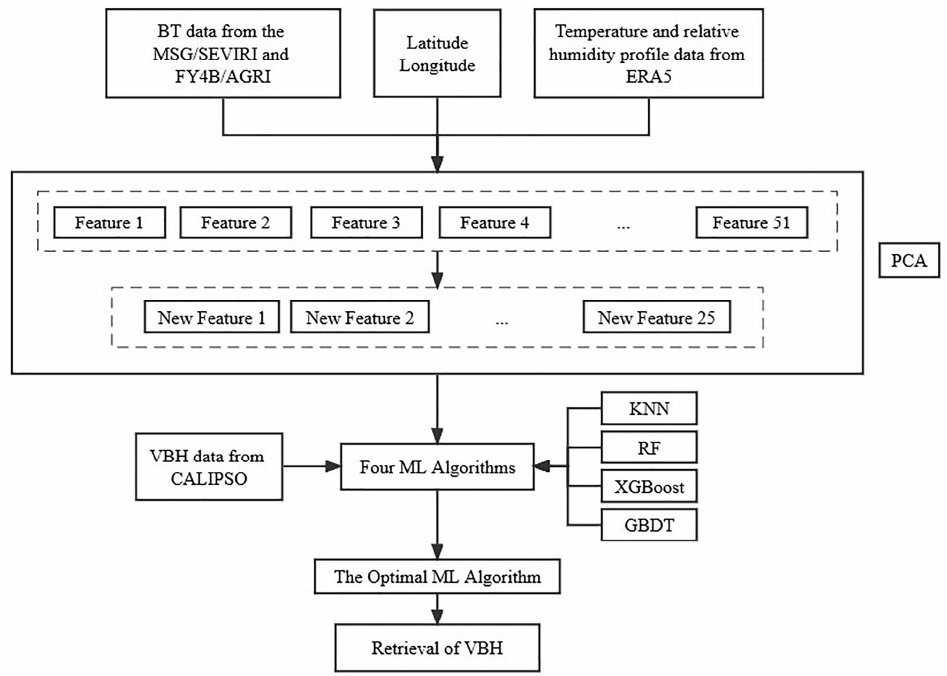
Figure 8. Flow chart of the VBH retrieval algorithm. The BT data, longitude, latitude, and the atmospheric profile data are taken as the input data, and the data dimension is reduced through PCA algorithm to obtain new features. The CBH data of CALIOP is taken as the “true value”. The optimal machine learning algorithm is selected to predict VBH by comparing the performance of KNN, RF, XGBoost and GBDT models.